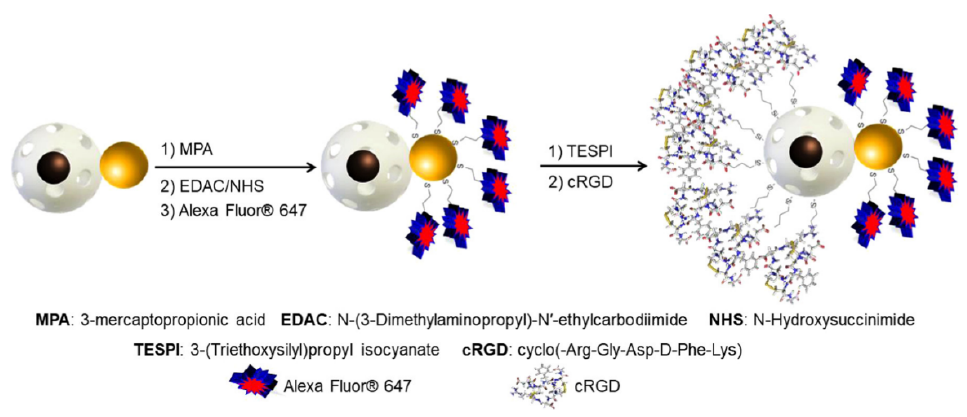
Figure 15. A schematic representing a multi-modal Janus nanoparticulate system composed of a SPION / MSN core / shell face and Au nanoparticle face. T 2 MRI contrast capabilities arise from the encapsulated SPION with Au nanoparticles providing the possibility for CT imaging. As shown in this schematic, the system is functionalised with a fluorescent dye (Alexa Fluor ® 647) for optical imaging in addition to cRDG for active tumour targeting. Reprinted with permission from reference [178]. Copyright (2018) American Chemical Society.